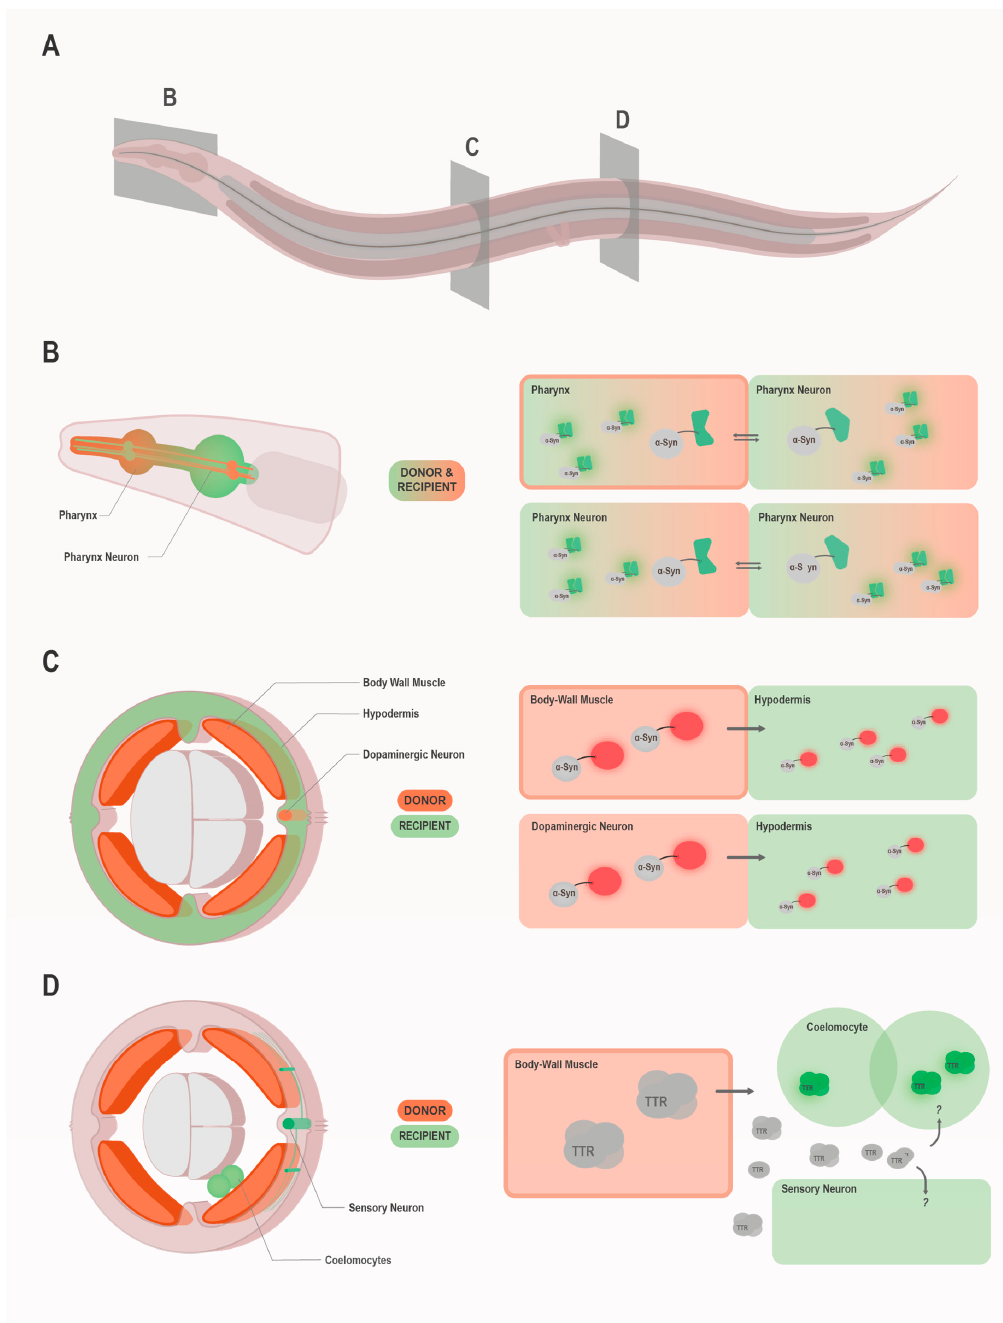
Figure 1. Overview of the currently established C. elegans models for prion-like propagation. The three different types of model systems and their working principles are illustrated using α -Syn and TTR as examples. Further models for other prion-like proteins are described in the text and listed in Table 1. ( A ) Schematic overview of C. elegans with the locations of the longitudinal and cross-sections, which are shown in more detail in panel B–D. ( B – D ) Longitudinal ( B ) or cross-sections ( C , D ) on the left show exemplary cells of the donor & recipient tissues within the worm. On the right-side, expression and transmission of the respective prion-like protein is shown schematically. Thick edges, as seen in pharynx and body wall muscle indicate presence of a tissue border (basement membrane). Large symbols represent construct that is expressed in the respective cell, while smaller symbols represent transmitted proteins and proteins formed after transmission. ( B ) Representation of C. elegans